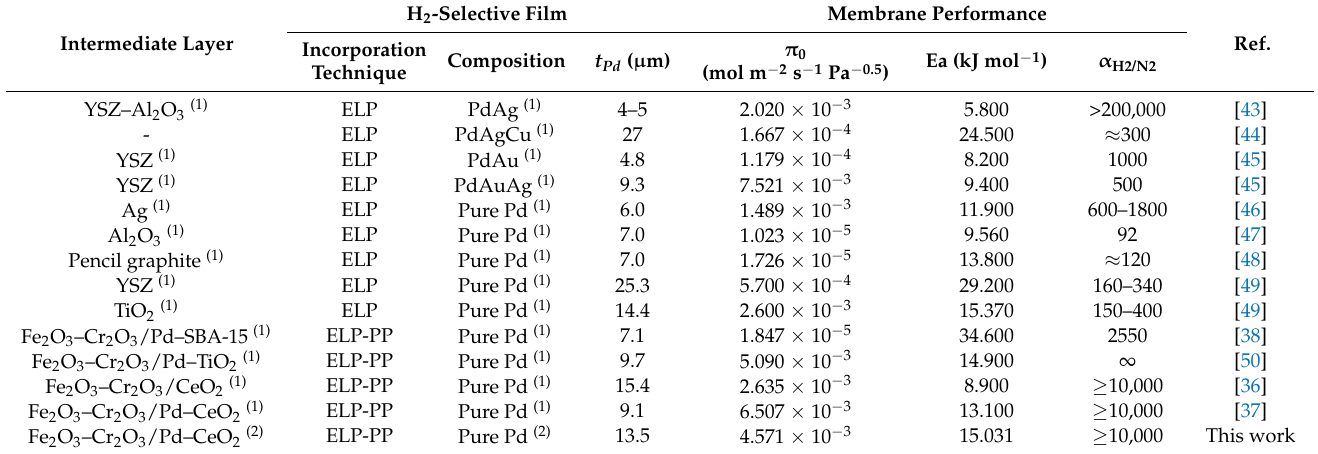
Table 2. Comparison of main characteristics and performance for relevant membranes in